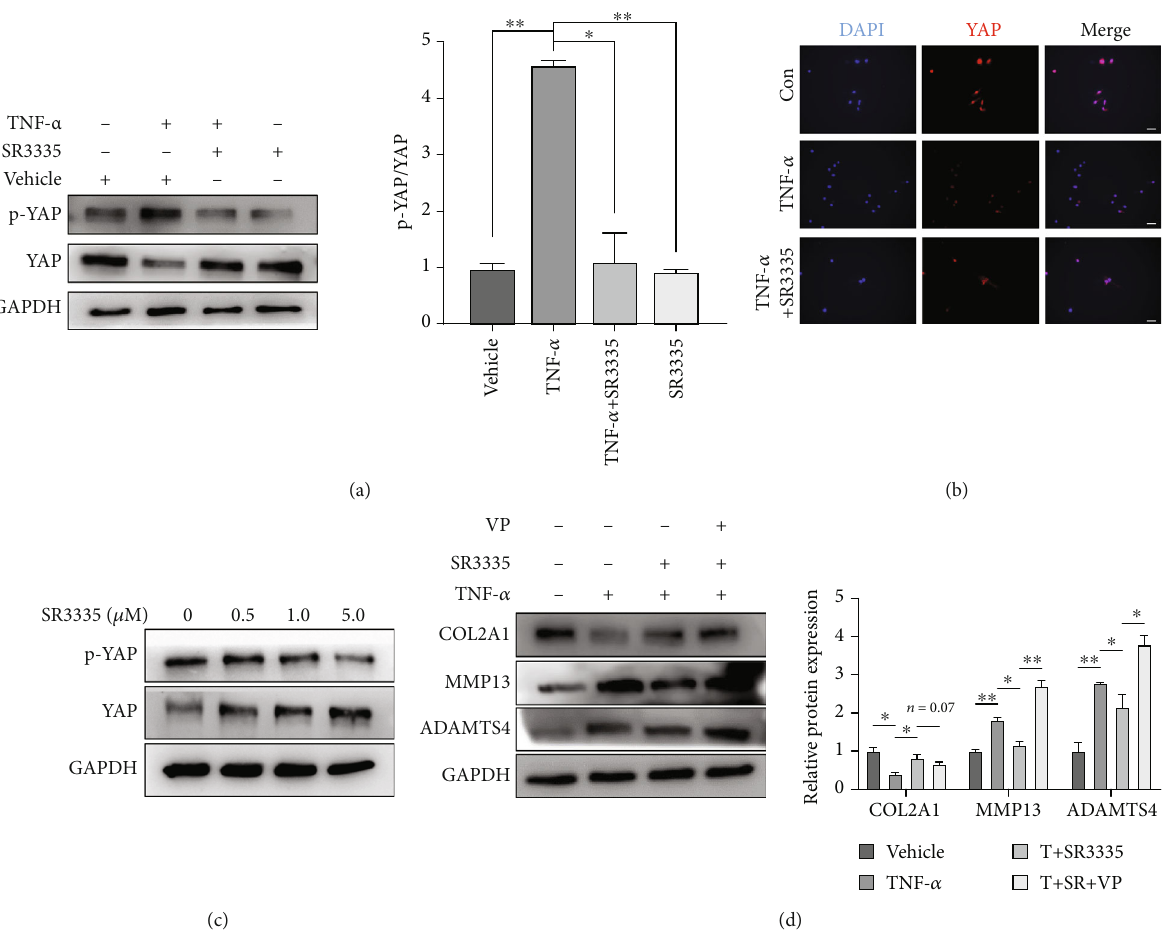
Figure 7: ROR α inhibition suppressed the phosphorylation and inactivation of YAP induced by TNF- α . (a) The expression levels of YAP and p-YAP were measured by western blot and quanti fi cation of p-YAP and YAP. The ratio of p-YAP/YAP was calculated. Data are expressed as mean ± SD . ∗ p < 0 : 05 and ∗∗ p < 0 : 01 compared with the TNF- α -treated group. (b) Immuno fl uorescence staining of YAP showed the location and relative fl uorescence strength under vehicle, TNF- α , TNF- α +SR3335 stimulation. Scale bar = 50 μ m . (c) NP cells were treated with various dosages of SR3335 (0, 0.5, 1.0, and 5.0 μ M) for 2 hours. The levels of p-YAP and YAP were assayed by western blot. (d) NP cells were treated with 10ng/ml TNF- α , 1 μ M SR3335, or 1 μ M VP for 24h. The protein level of COL2A1, MMP13, and ADAMTS4 was assayed by western blot and quanti fi cation. All experiments were repeated three